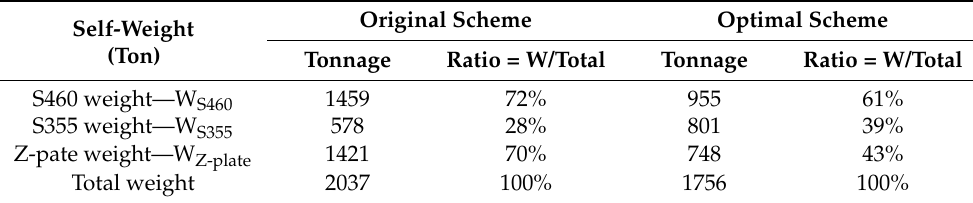
Table 4. Comparison of steel weight corresponding to steel grade and Z plate.